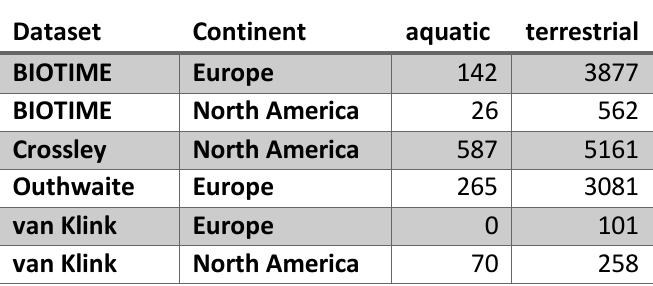
Table S2: Number of original time series across datasets, continents and habitats, at the end of